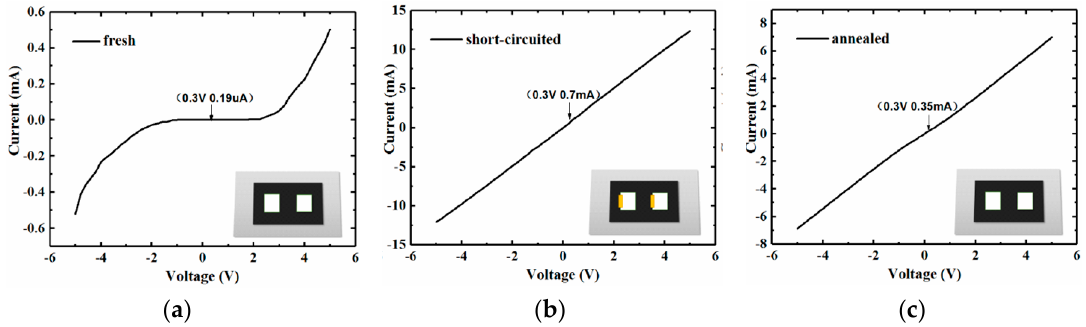
Figure 4. I-V curves of ( a ) freshly prepared, ( b ) short-circuited and ( c ) annealed sensors.